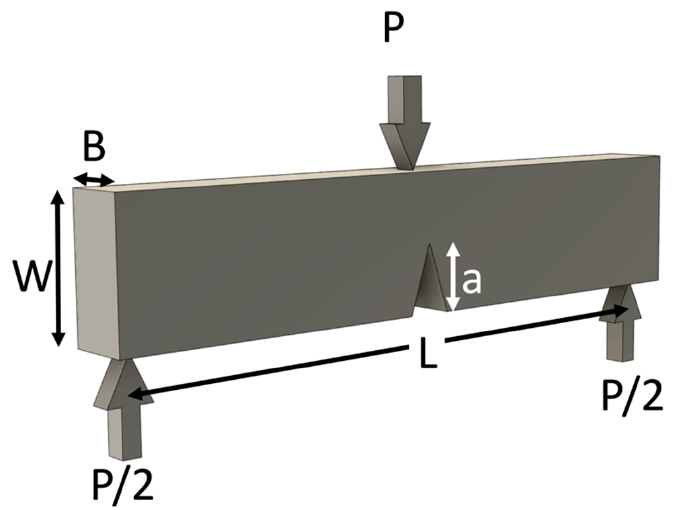
Figure 2. Test to measure fracture toughness using the bend test with a pre ‐ notched specimen.